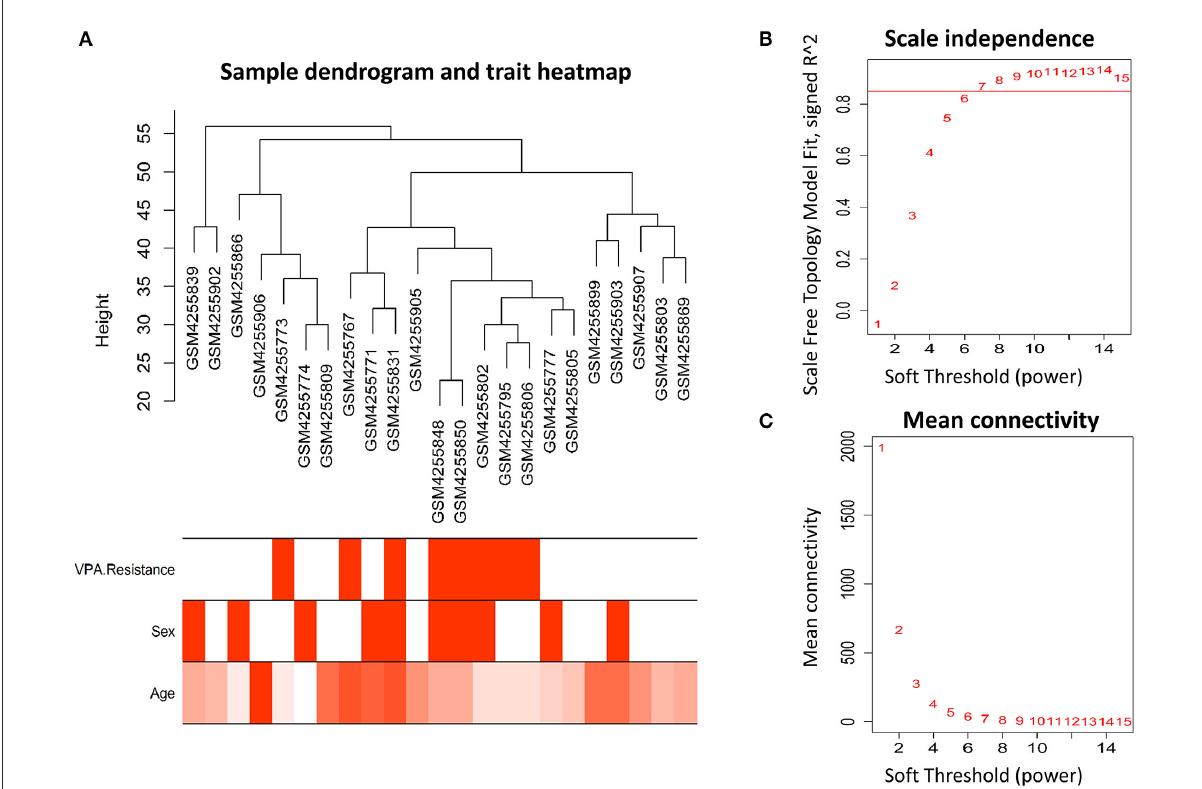
FIGURE2 Clustering of samples and identification of soft-thresholding power. (A) The microarray dataset GSE143272 contained 9 VPA-resistant and 16 VPA-responsive samples. After clustering and removing two outliers, the remaining 23 samples were analyzed. The different color below denoted different disease status (VPA resistance, gender, and age). (B) The scale-independence and (C) mean connectivity for different soft threshold powers were calculated, and 7 was selected as the most fit power value to construct scale-free networks (VPA, valproate).